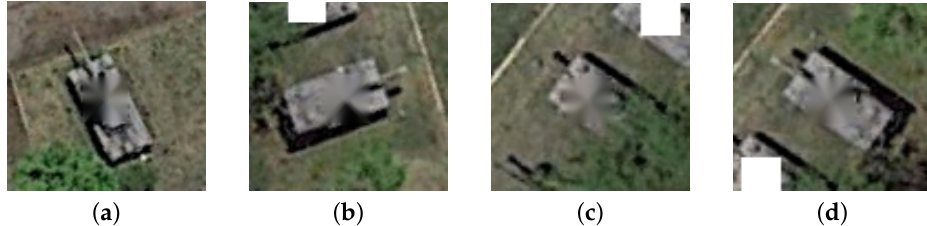
Figure 5. ( a – d ) Inpainting the adversarial patch area using traditional algorithms. Although the colors are similar, almost all the semantic and texture information in the inpainted area is lost, which is fatal to the detector.